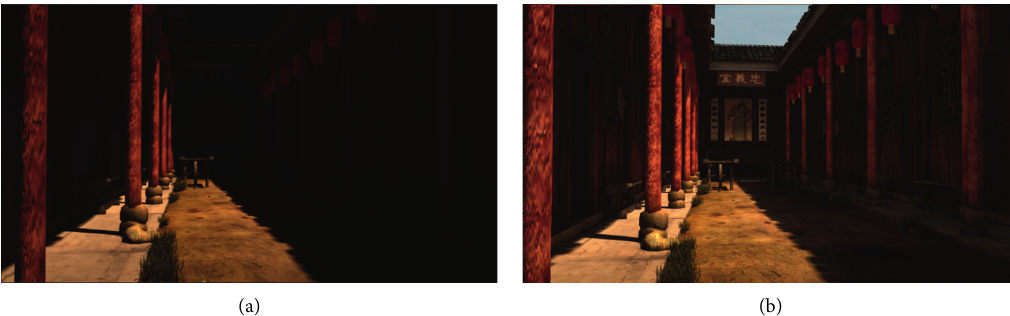
Figure 12: One light illuminates the building with a high contrast of light and shadow (a); multiple lights illuminate the building with the right contrast of light and dark, making the picture more vivid (b).